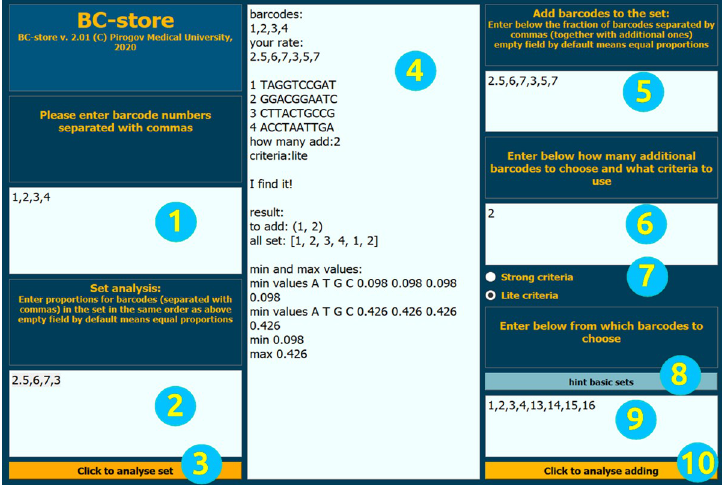
Fig 12. Layout of the desktop version with numbering of input fields and buttons. 1 –enter the current set, 2 –enter set proportions, 3 –set analysis button, 4 –output field, 5 –input proportions of the current set with the new barcodes, 6 –enter the number of new barcodes, 7 –select criteria, 8 –tip for base sets, 9 –input the barcode to choose from, 10 – start analysis of set selection.